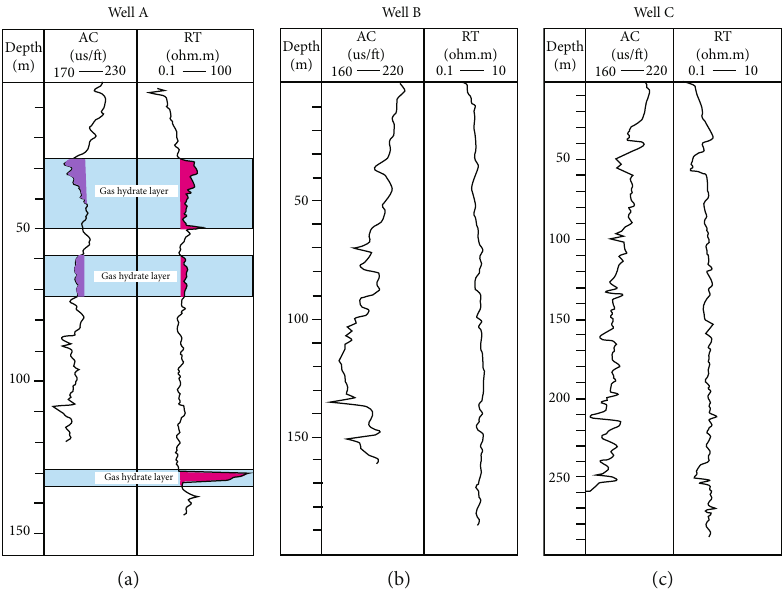
Figure 7: Logging curves of well A (a), well B (b), and well C (c) in the